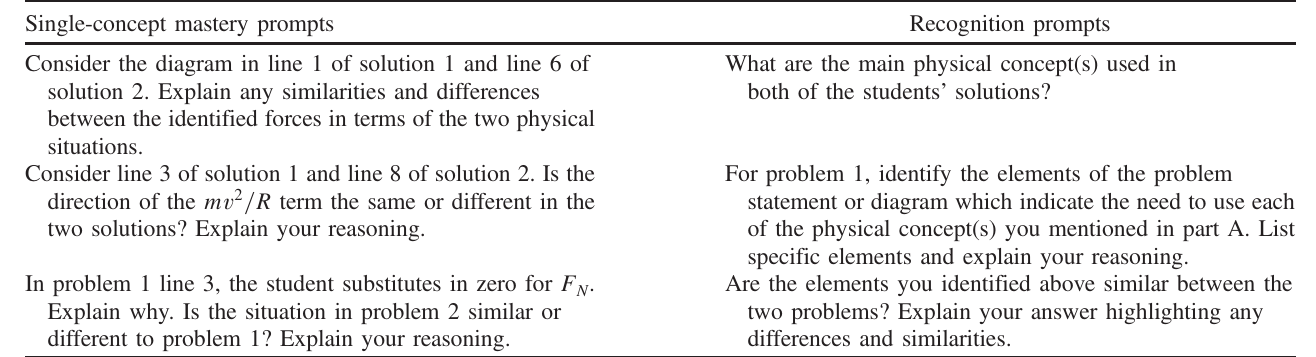
TABLE I. Examples of the written prompts provided to students along with the worked examples. Single-concept mastery